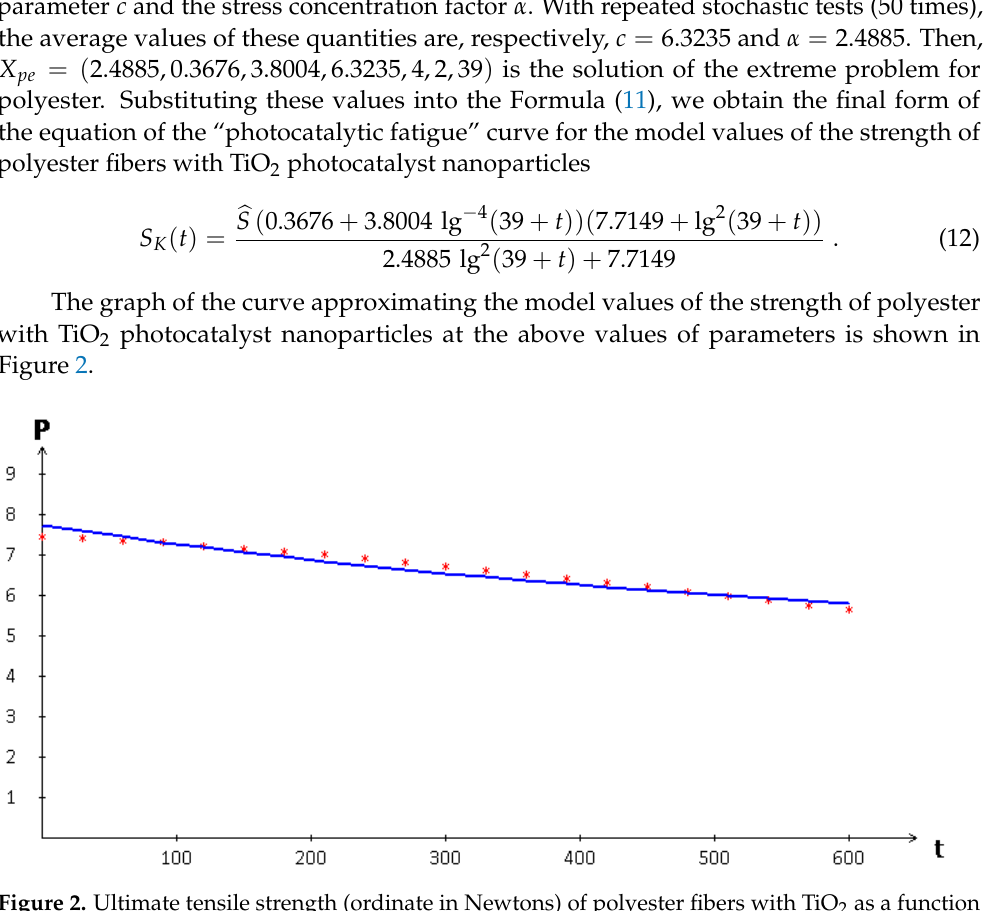
Figure 2. Ultimate tensile strength (ordinate in Newtons) of polyester fibers with TiO 2 as a function of irradiation time (abscissa in minutes). The asterisks on the graph are the model data, and the curved line is the results of the approximation of the model data by Equation (12), the coefficients of which are obtained by the Monte Carlo